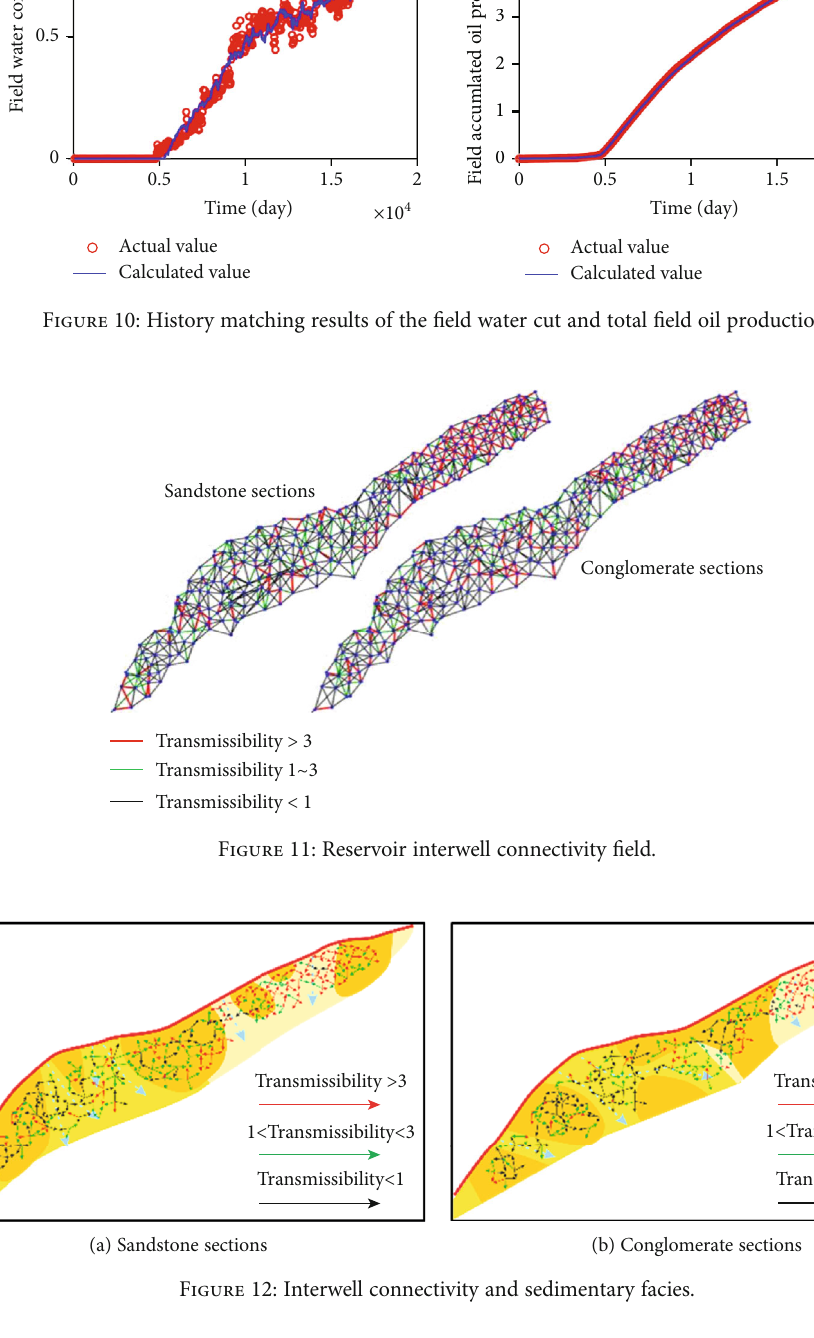
Figure 12: Interwell connectivity and sedimentary